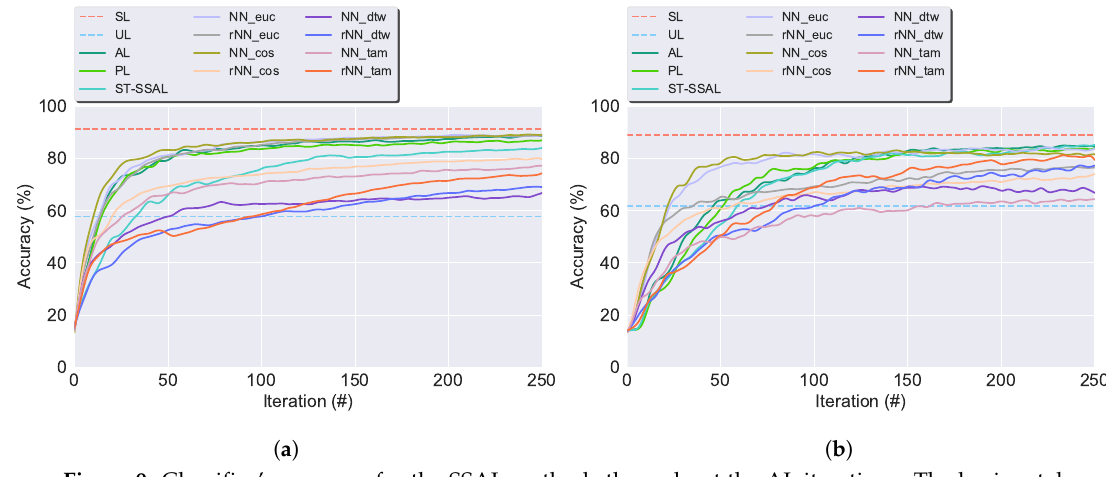
Figure 9. Classifier’s accuracy for the SSAL methods throughout the AL iterations. The horizontal lines denote the 10-CV average accuracy for SL (in red), and UL ARI score (in blue). Following the underscore in the NN and rNN methods: Euc, Cos, Dynamic Time Warping (DTW) and Time Alignment Metric (TAM), denote the distances used. ( a ) UCI dataset. ( b ) CADL